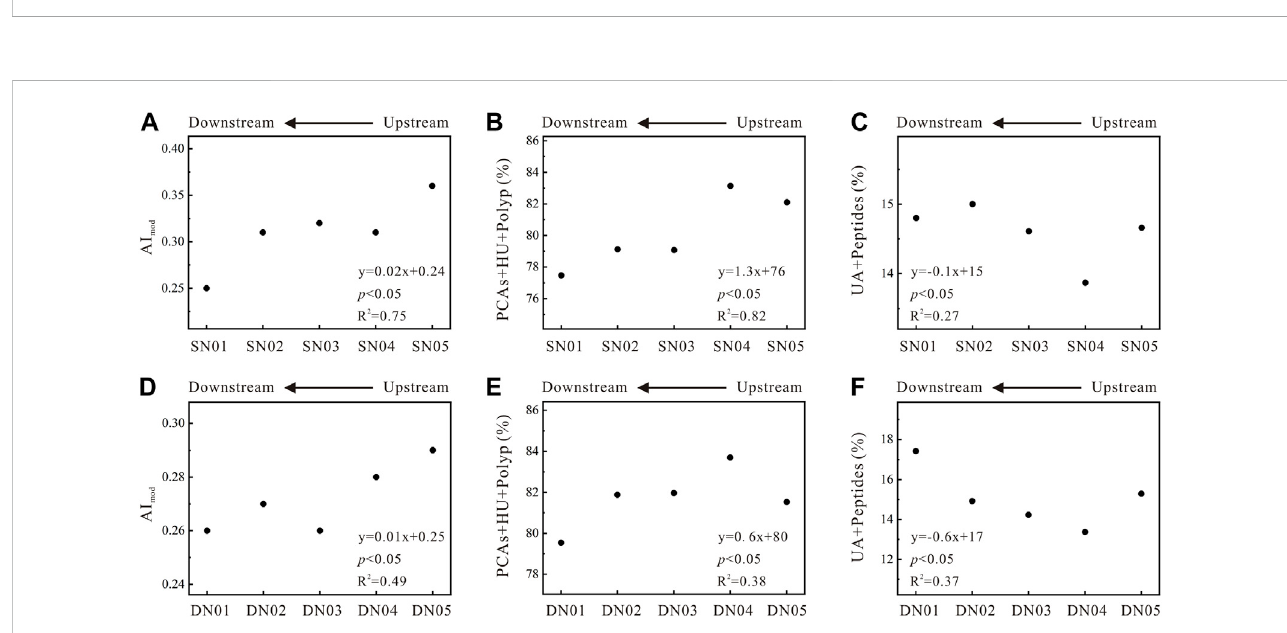
FIGURE 4 Molecular propertiesofWEOMinSNRandDNR. (A) AI mod , (B) PCAs+HU+polyp,and (C) UA+peptidesinSNR; (D) AI mod , (E) PCAs+HU+polyp,and (F) UA + peptides in DNR. Note: AI mod , modi fi ed aromaticity index; PCAs, polycyclic aromatics; HU, highly unsaturated compounds; polyp, polyphenols; UA, unsaturated aliphatic